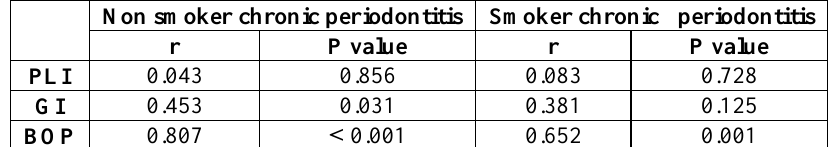
Table 5: correlations of (PLI, GI and BOP) and MMP-9 levels in smokers and non smokers